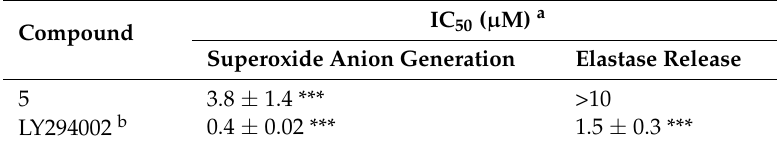
Table 2. Inhibitory effects of isolated compounds on superoxide anion generation and elastase release by human neutrophils in response to N -formyl- L -methionyl-phenylalanine/cytochalasin B (fMLP/CB).